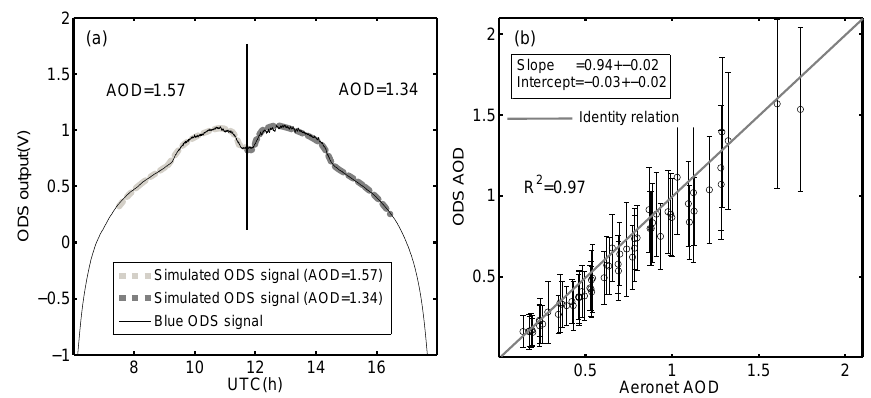
Figure 15. (a) Evolution of ODS signal measured on 5 January 2005 and those simulated for the AOD values obtained by the retrieval procedure of dust opacity using only half of the day. (b) Correlation between ODS blue channel and AERONET AOD at 370nm for cloud- free days, and where two values of AOD per day have been estimated for days with a daily average AOD above 0.8.